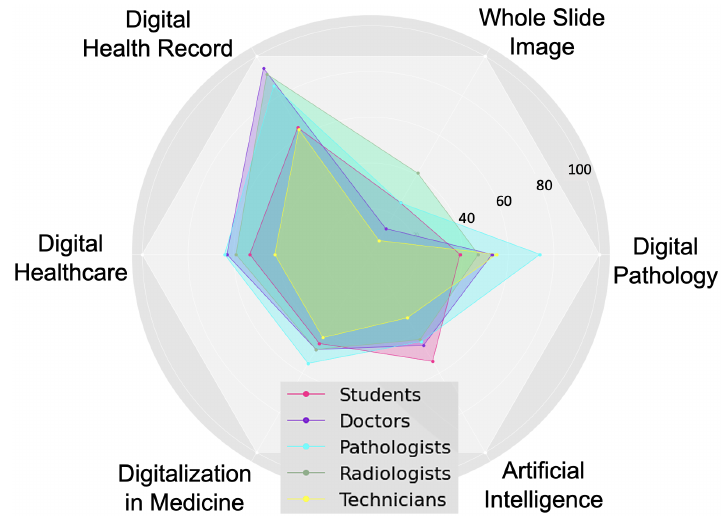
Figure 12. Familiarity score distribution among professionals.